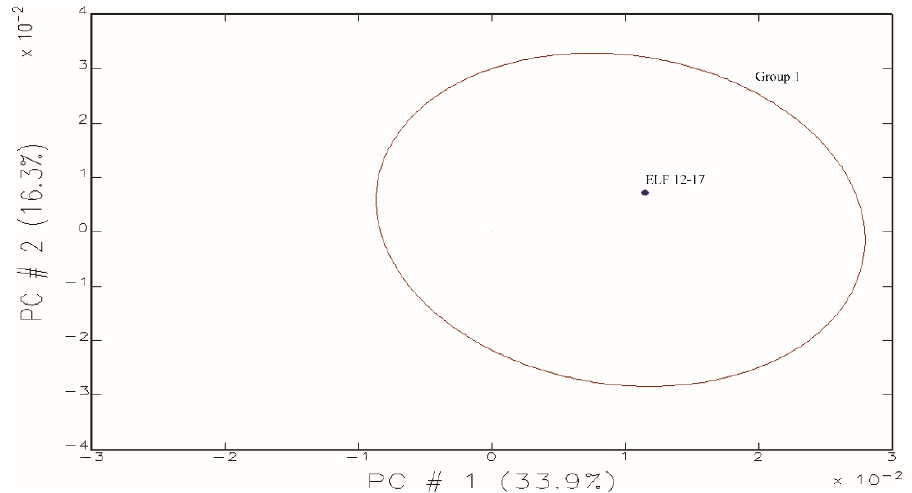
Figure 17. Scatterplot comparing PC 1 and PC 2 from the Saronic Gulf Core Group 1 [95] assemblage demonstrating the location of ELF 12/17 in Group 1. Image by William Gilstrap. Table 3. Mean compositional concentrations for elements measured in Chemical Groups 1 and 3. All data are reported in ppm unless otherwise stated.